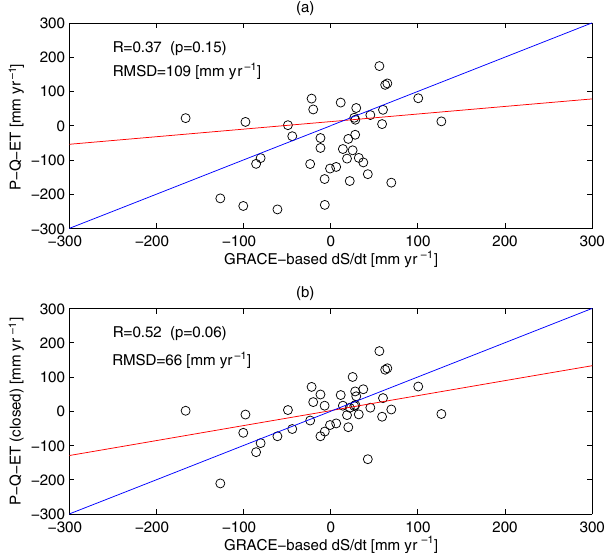
Figure 3. (a) Relationship between annual P − Q − E T and gravity- based d S GR / d t within each of the large-scale basins listed in Ta- ble 1. (b) Same, except that annual P − Q − E T time series for each basin have been closed (i.e., modified to sum to zero over the 8- year data record). The blue line is a one-to-one line and red line is the least-squares linear